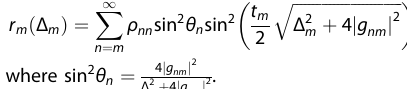
ffiffiffiffiffiffiffiffiffiffiffiffiffiffiffiffiffiffiffiffiffiffiffiffiffiffiffi